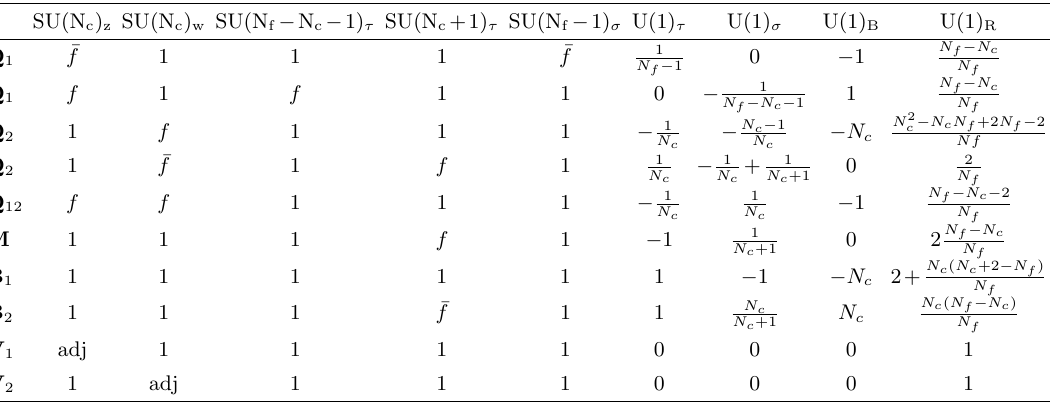
Table 4 . The matter content of the quiver gauge theory whose (cid:12)eld content corresponds to the superconformal index I quiver ; T given by eq. (4.3).